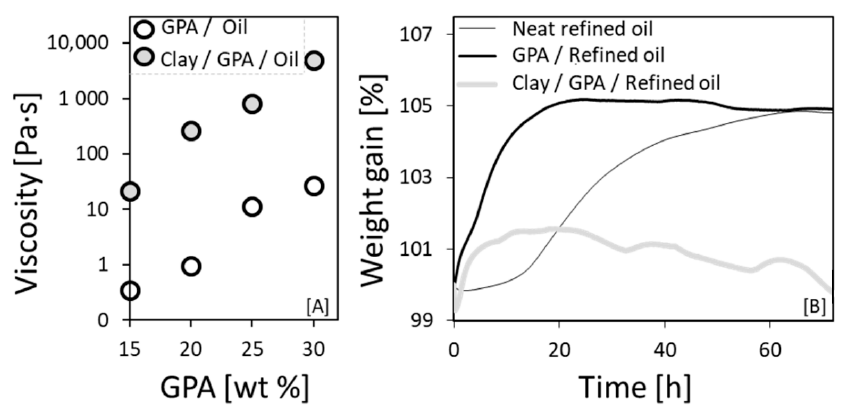
Figure 5. Effect of clay on the linseed oil–graphite powder composite: ( A ) Zero-shear (at 0.1 Hz shear